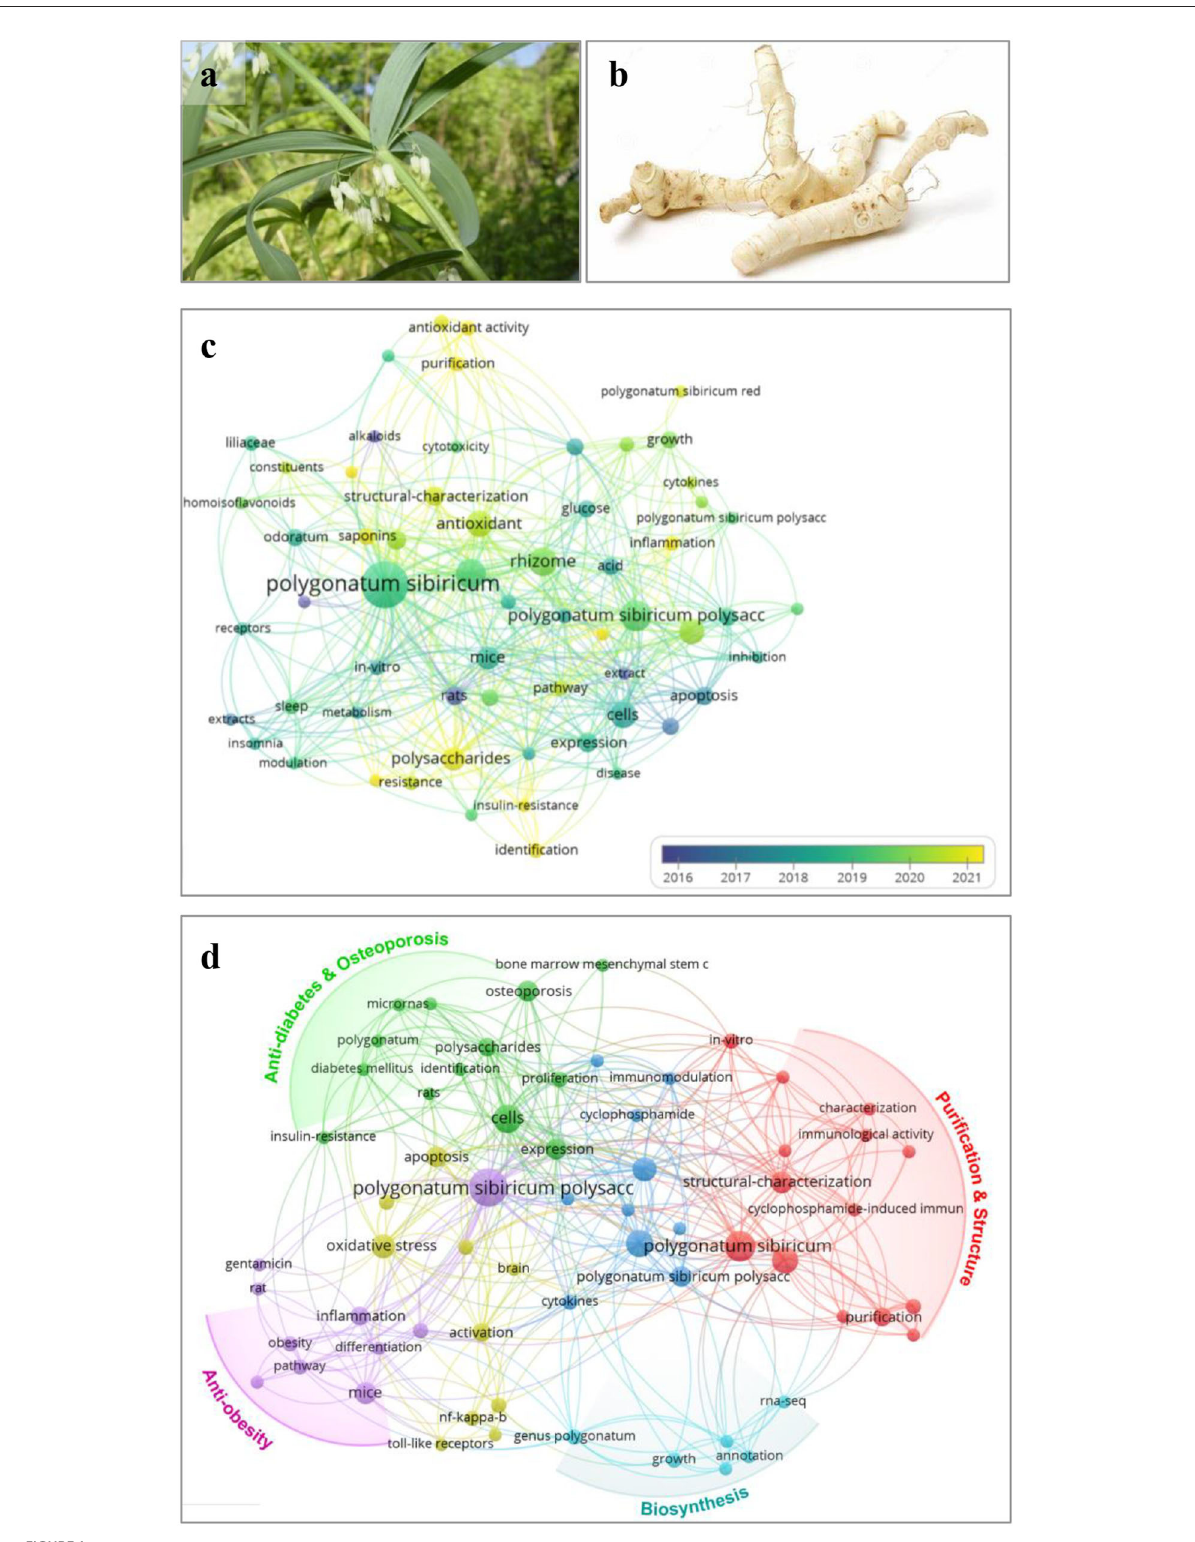
FIGURE1 Photos of aerial part (a) and rhizome (b) of Polygonatum sibiricum and bibliometric analysis (c,d) based on papers related to P. sibiricum and its polysaccharides. Bibliometric analysis of Polygonate sibiricum research based on papers published on Web of Science core collection with the topic of “ Polygonatum sibiricum ”/“ Polygonatum ” without specific year-published restriction up to 28/09/2022. (c) Map of co-occurrence network of keywords based on retrieval of “ Polygonatum sibiricum. ” (d) Map of co-occurrence network of author keywords based on retrieval of “ Polygonatum sibiricum AND